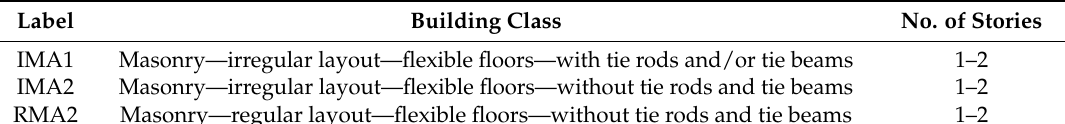
Table 2. Building typologies selected from those of [23].